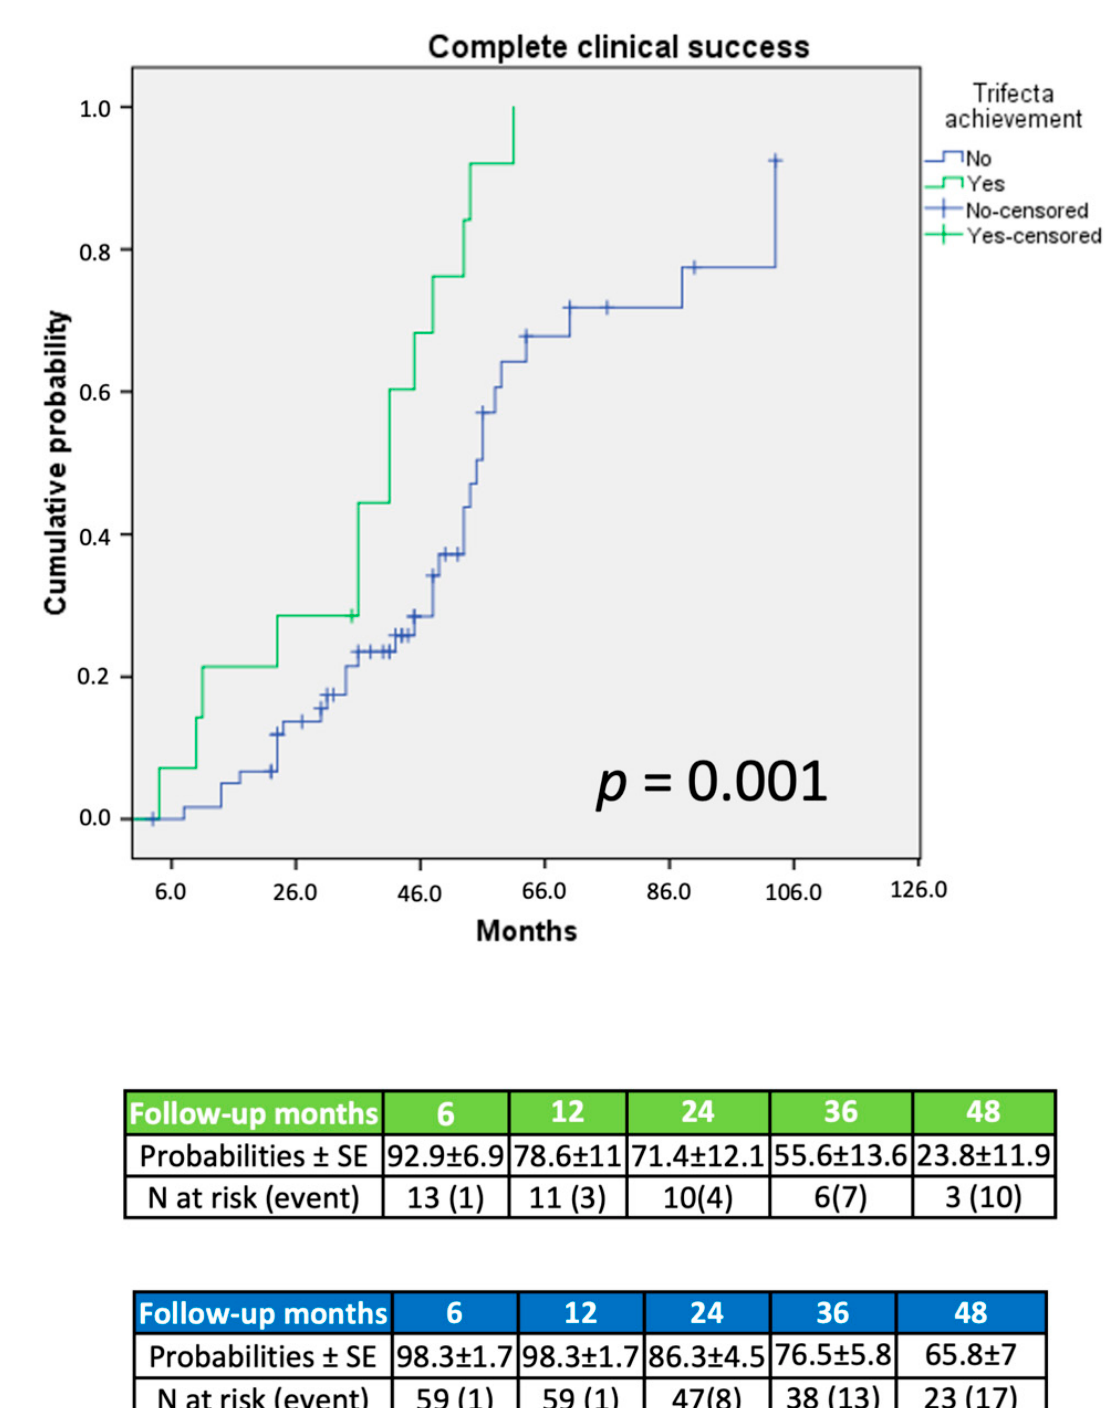
Figure 1. Probability of complete clinical success according to PASO criteria.